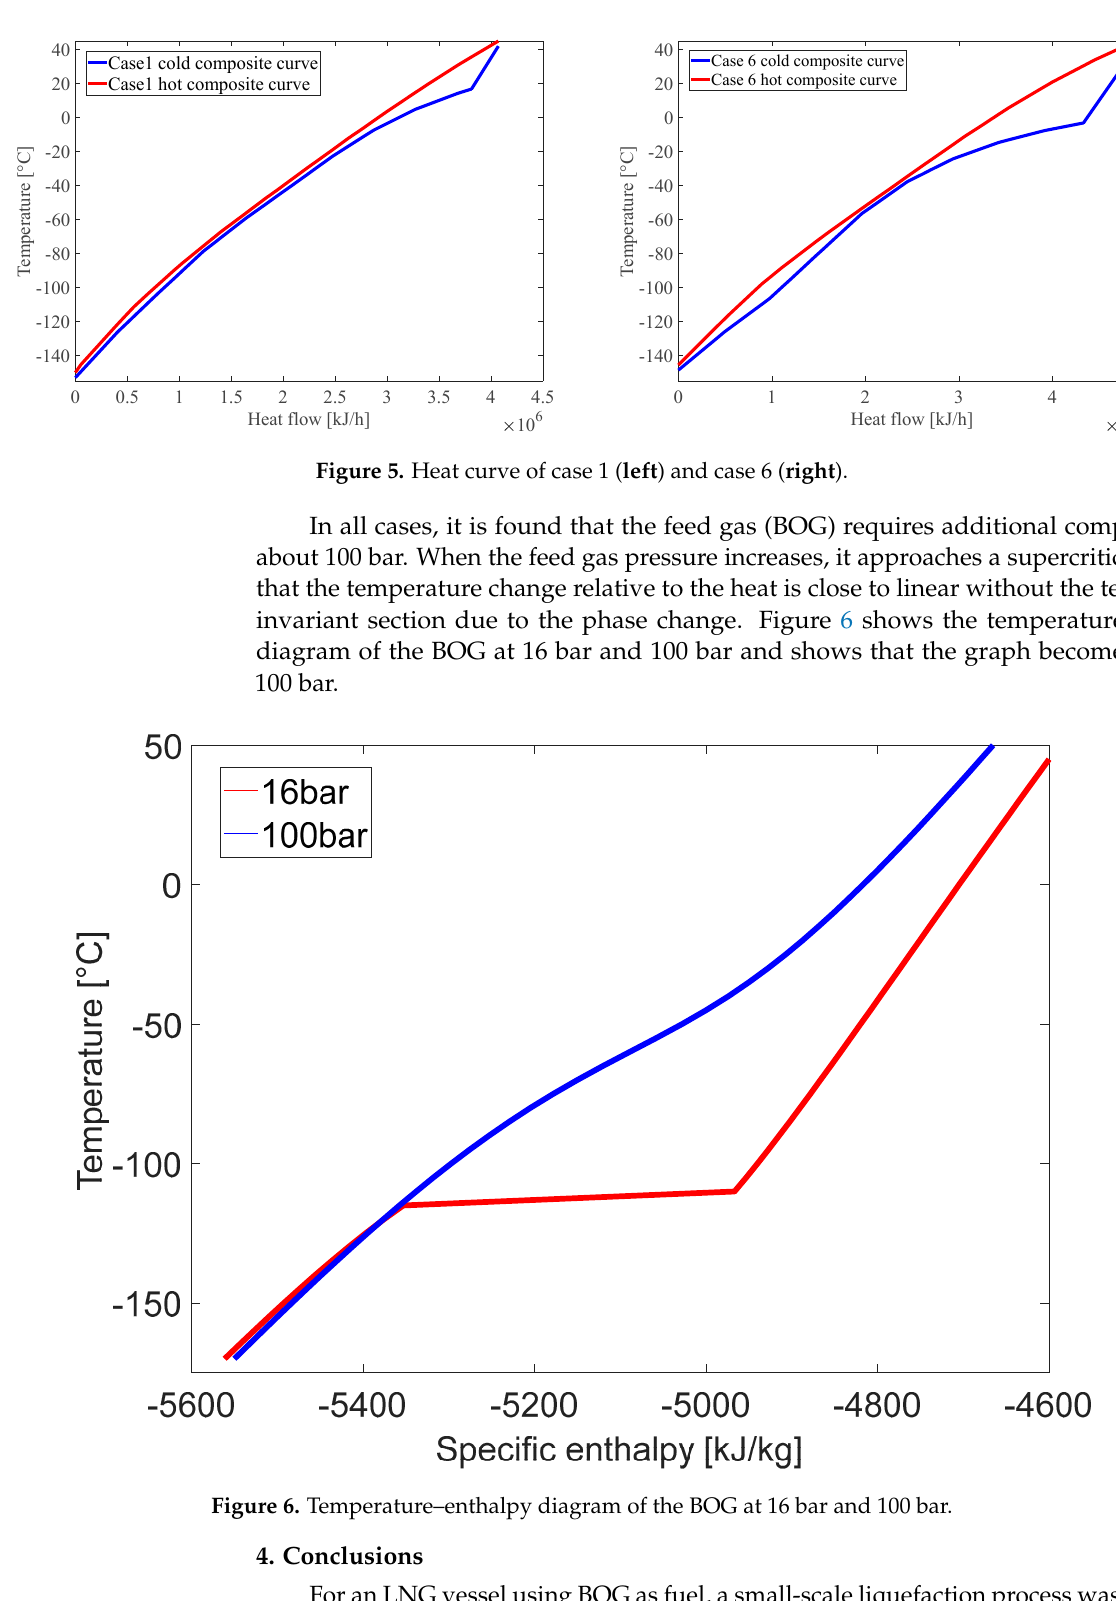
Figure 6. Temperature–enthalpy diagram of the BOG at 16 bar and 100 bar.